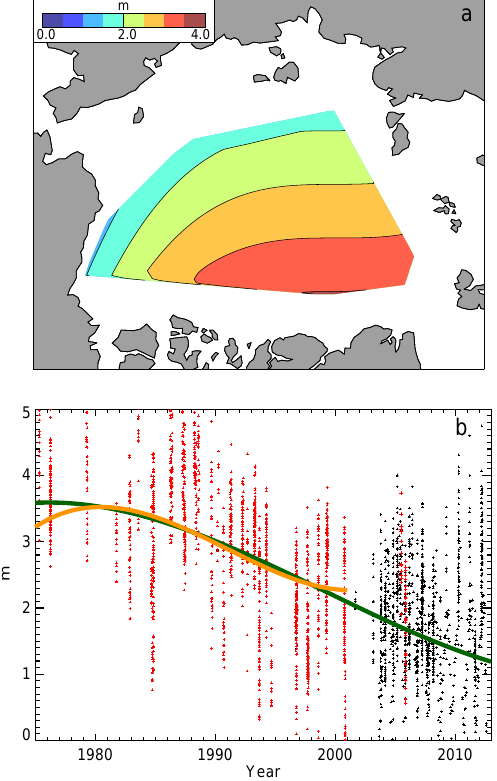
Figure 5. (a) Map of the annual mean ice thickness in the SCICEX box and (b) time series of the annual mean. The orange line is the third-order polynomial from RPW08 for which the draft was con- verted to thickness with a factor of 1.107. The green line is a third- order polynomial from this study. The dots show the observations from within the box; red are from the